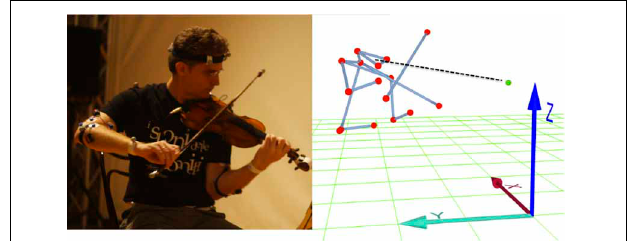
FIGURE 2 | Picture and Motion Capture (MoCap) data of the first violinist of Quartetto di Cremona. The dashed line represents the main dependent variable, that is, the distance between the musician’s head center of gravity (COG) and the ear, the subjective center of the string quartet.